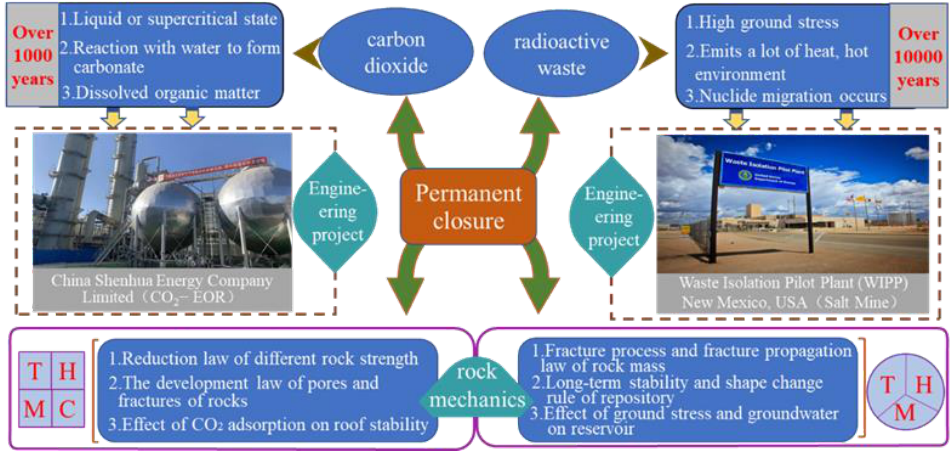
Figure 13. Use of abandoned mines for permanent CO 2 and radioactive waste sequestration.